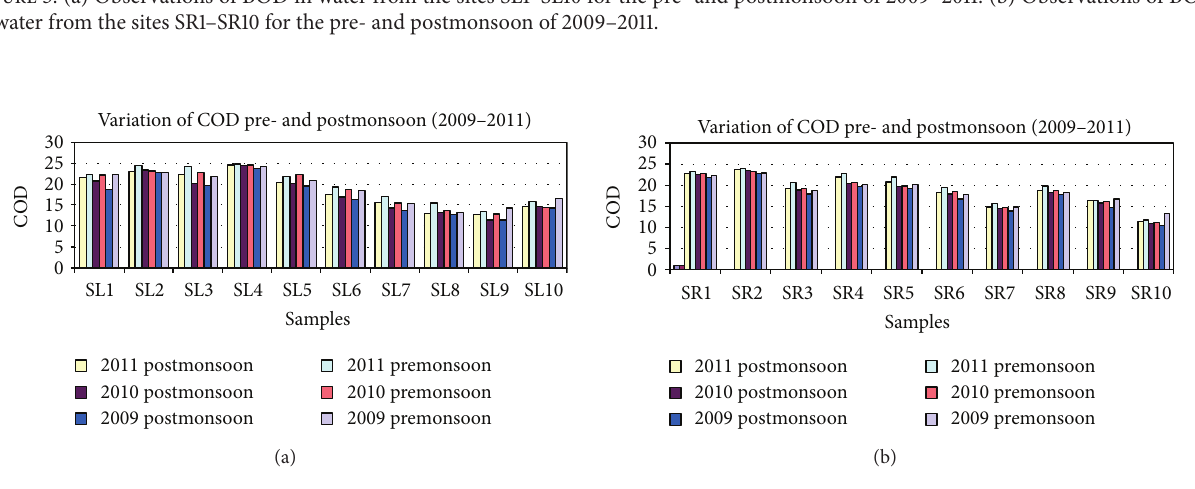
the samples were found to be between 0.025 and 0.087